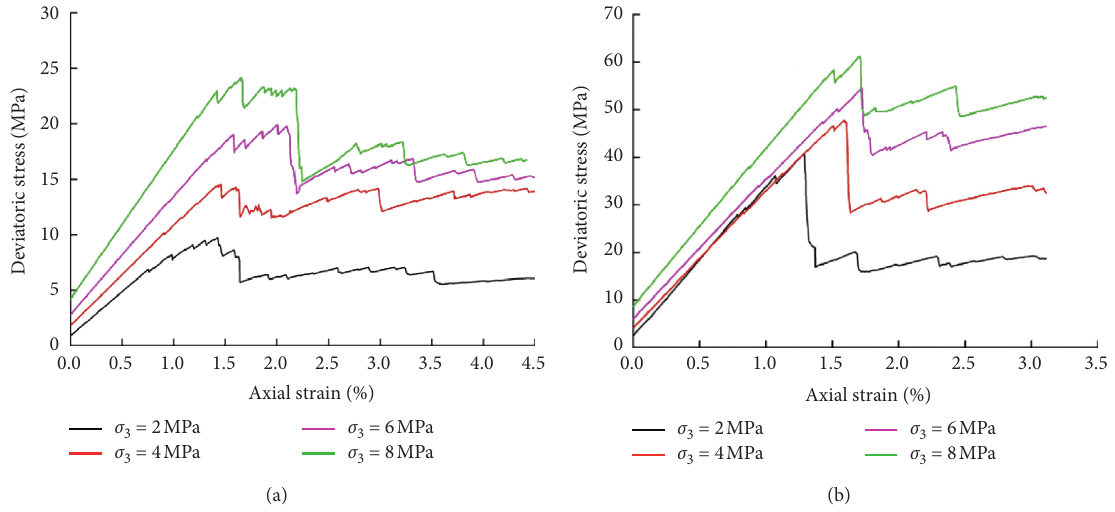
Figure 8: Stress-strain curve of rock numerical triaxial test. (a) Mudstone. (b)